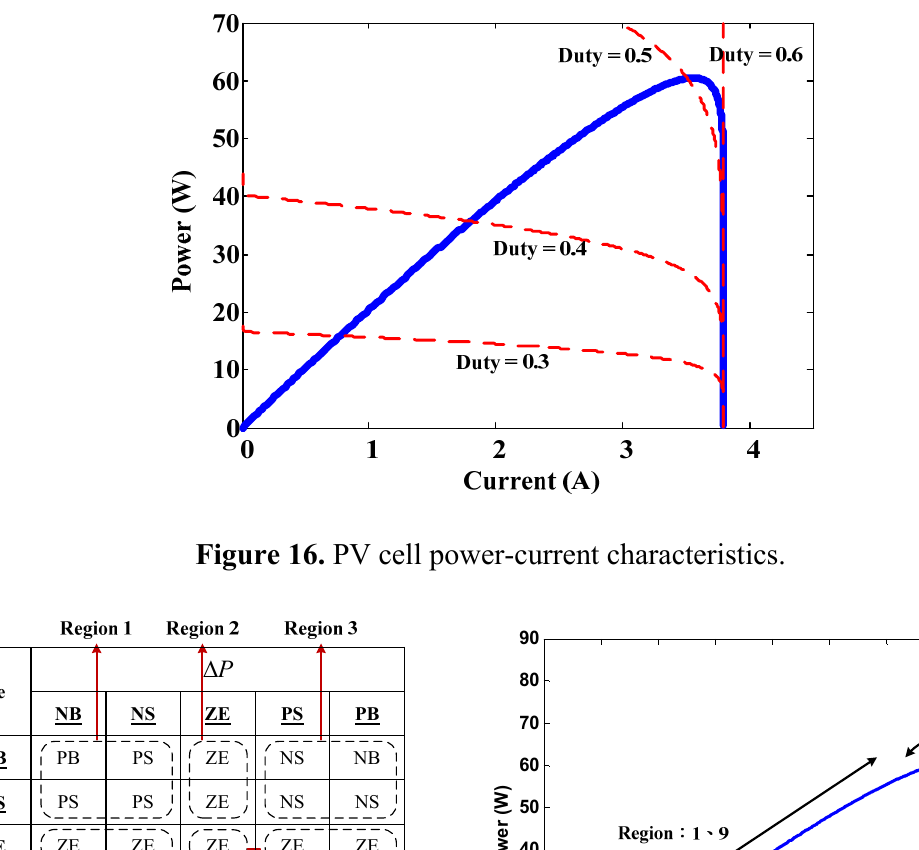
Algorithm (iv): Variation of Power and Variation of Current as Inputs